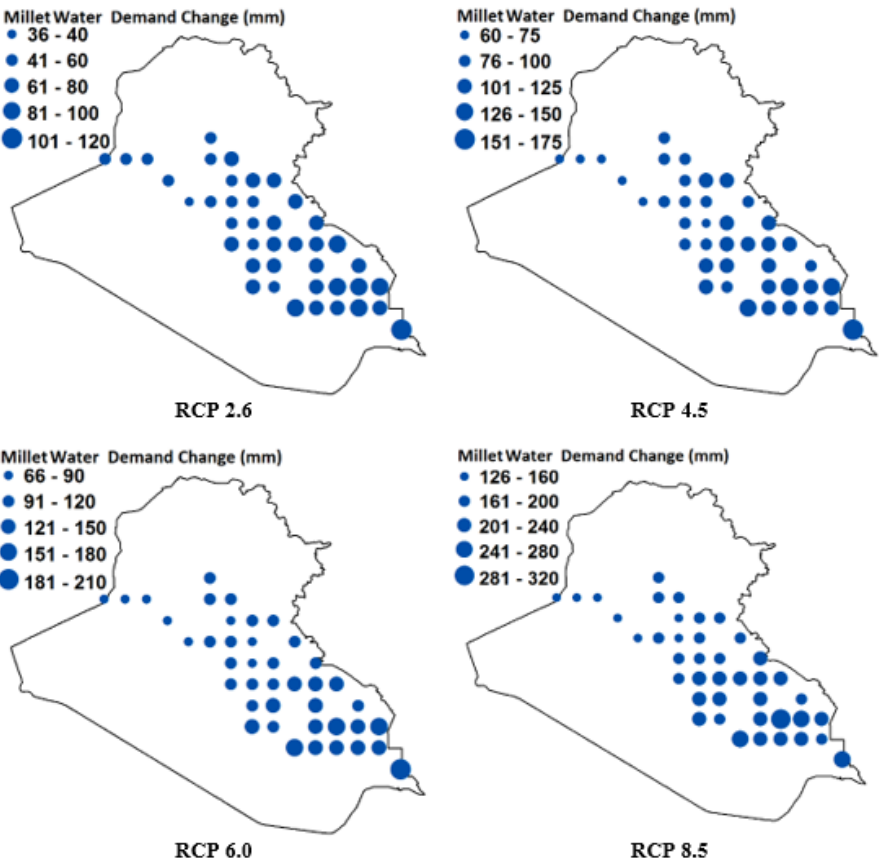
Figure 9. The geographical variations of the changes of the water needs for millet between 2070 and 2099 and 1971 and 2000 for four RCPs.